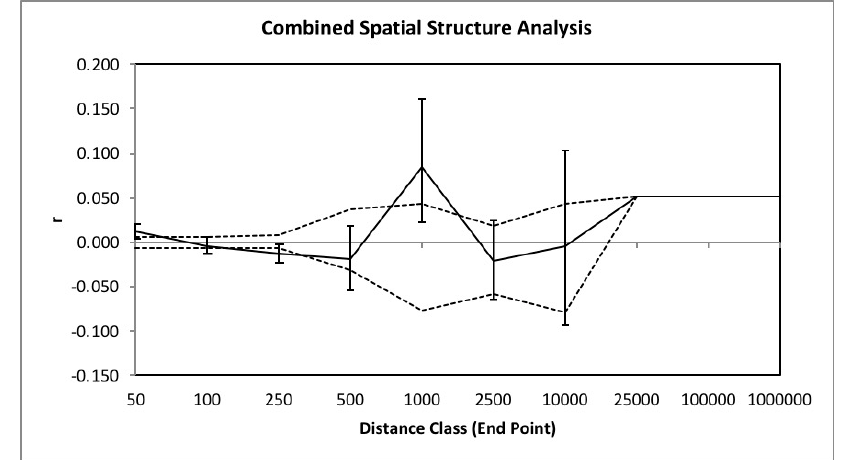
Figure 3. Spatial autocorrelation analysis. Distance classes (meters) were assigned to represent the distances between clones in a population ( ≤ 50 m) and the distances between populations at different sites ( ≥ 1000 m). Dashed lines indicate the upper and lower 95% confidence intervals while the solid line indicates the calculated r . Positive spatial structure appears at 50 m within a population and then again at 1 km among sites. Agriculture 2019 , 9 , x FOR PEER REVIEW